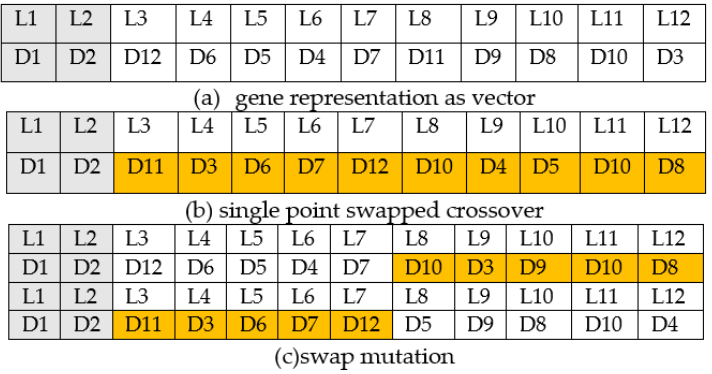
Figure 3. Crossover and Mutations.